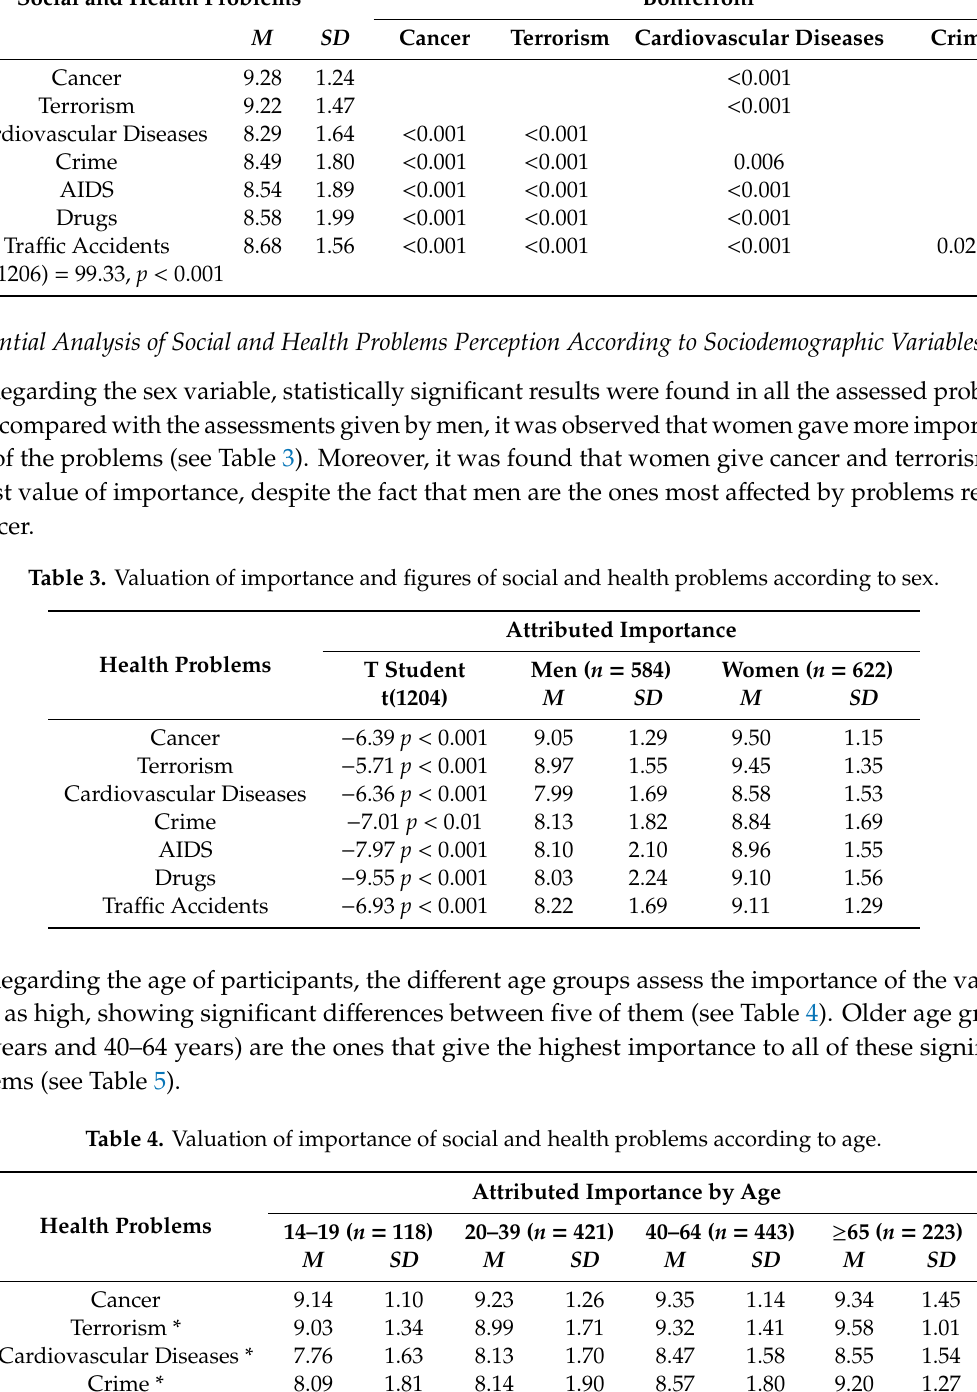
Table 2. Post hoc analysis for inter-subject di ff erences in the assessment of social and health problems. Social and Health Problems Bonferroni Cancer